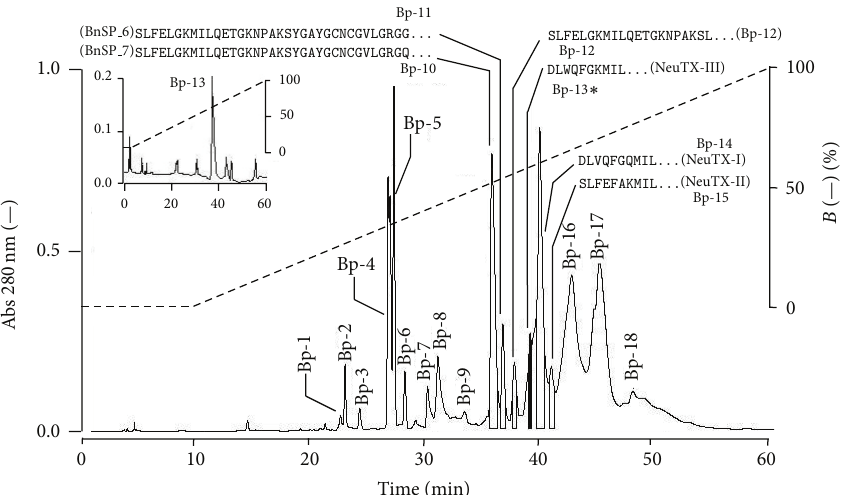
Figure 1: RP-HPLC chromatography of Bothrops pauloensis venom on 𝜇 -Bondapak C 18 column (0.78 cm × 30 cm; Waters 991-PDA system Waters). A sample of 20 mg from venom was eluted with solvent B (acetonitrile, 0–66%) at 25 ∘ C. The elution profile was monitored at 280 nm. The main fractions obtained are identified as